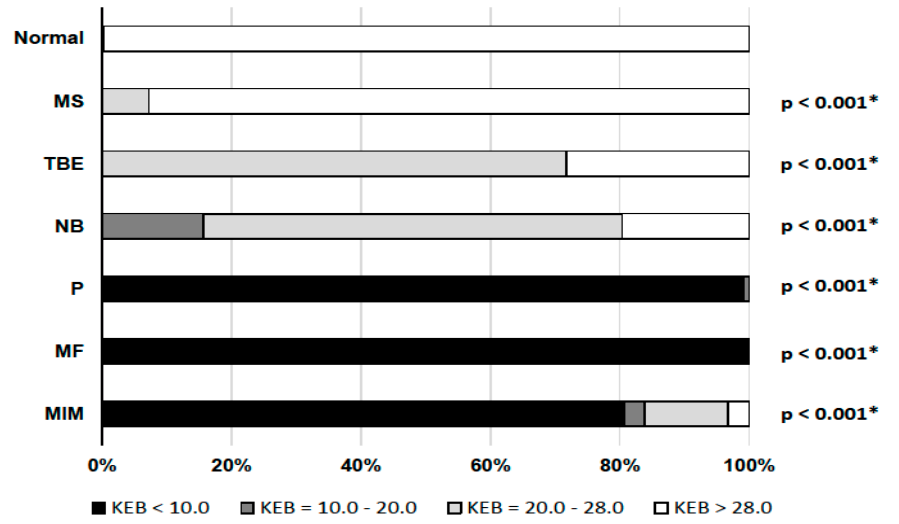
Figure 7. Distribution of KEB values in subgroups of our patients (*: statistically significant).